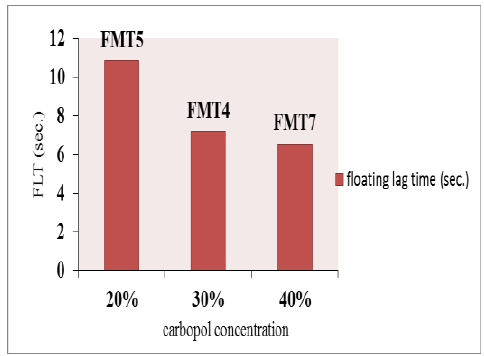
Figure (9) Histogram showing the effect of carbopol 934p concentration on FLT The low level of polymer in FMT5 caused the poor strength of the gel layer and hence could not sustain the amount of gas generated as shown in figure 10. Therefore, BFN floating microsponge tablets formulated with 30 % and 40 % carbopol 934 p polymer showed an acceptable tablet shape with excellent FLT and TFT and good gel strength layer that maintained integrity of the tablets.